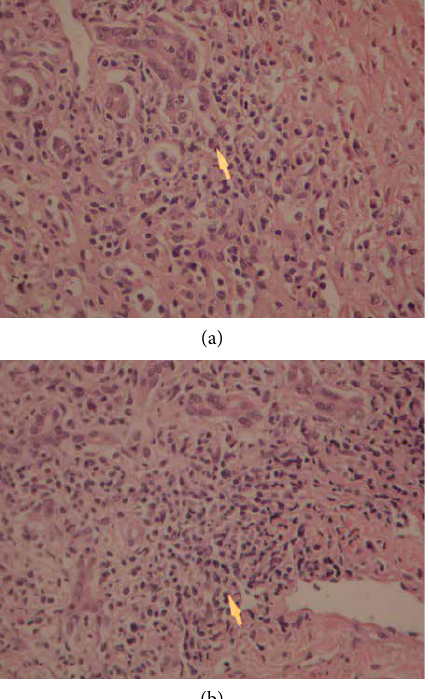
Figure 3: Liver biopsy showing moderate to marked portal tract mostly lymphoplasmacytic inflammatory cell infiltrate. HE: 10 ×